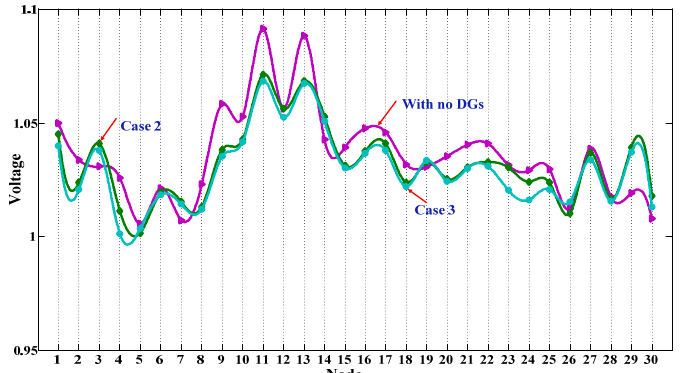
Figure 8. Voltage variations at each node with added DGs in case n .